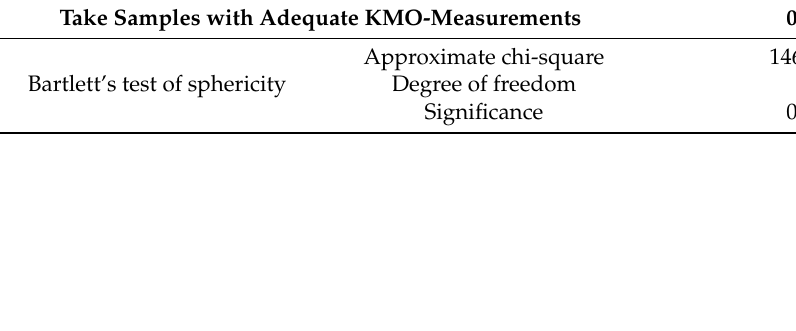
Table 4. Exploratory-factor test